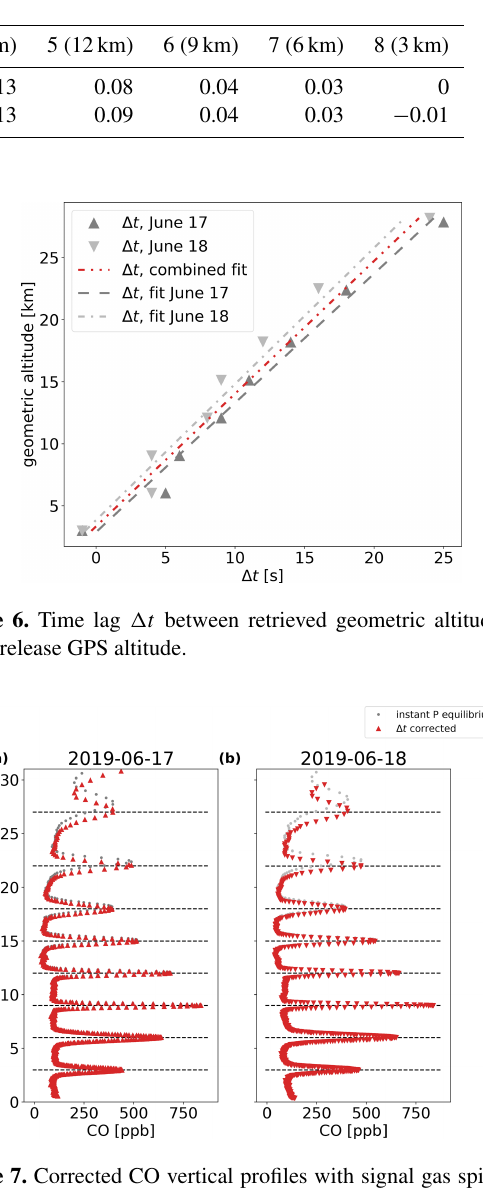
Figure 7. Corrected CO vertical profiles with signal gas spikes on (a) 17 June (red triangles pointing upwards) and (b) 18 June (red triangles pointing downwards), Traînou, 2019. The dashed lines in- dicate the signal release GPS altitudes. CO measurements are at- tributed to geometric retrieval altitudes assuming an instantaneous pressure equilibrium between AirCore and ambient air during sam- pling (data from Fig. 5 shown as grey circles). The individual pro- files were corrected with (cid:49)t from the combined